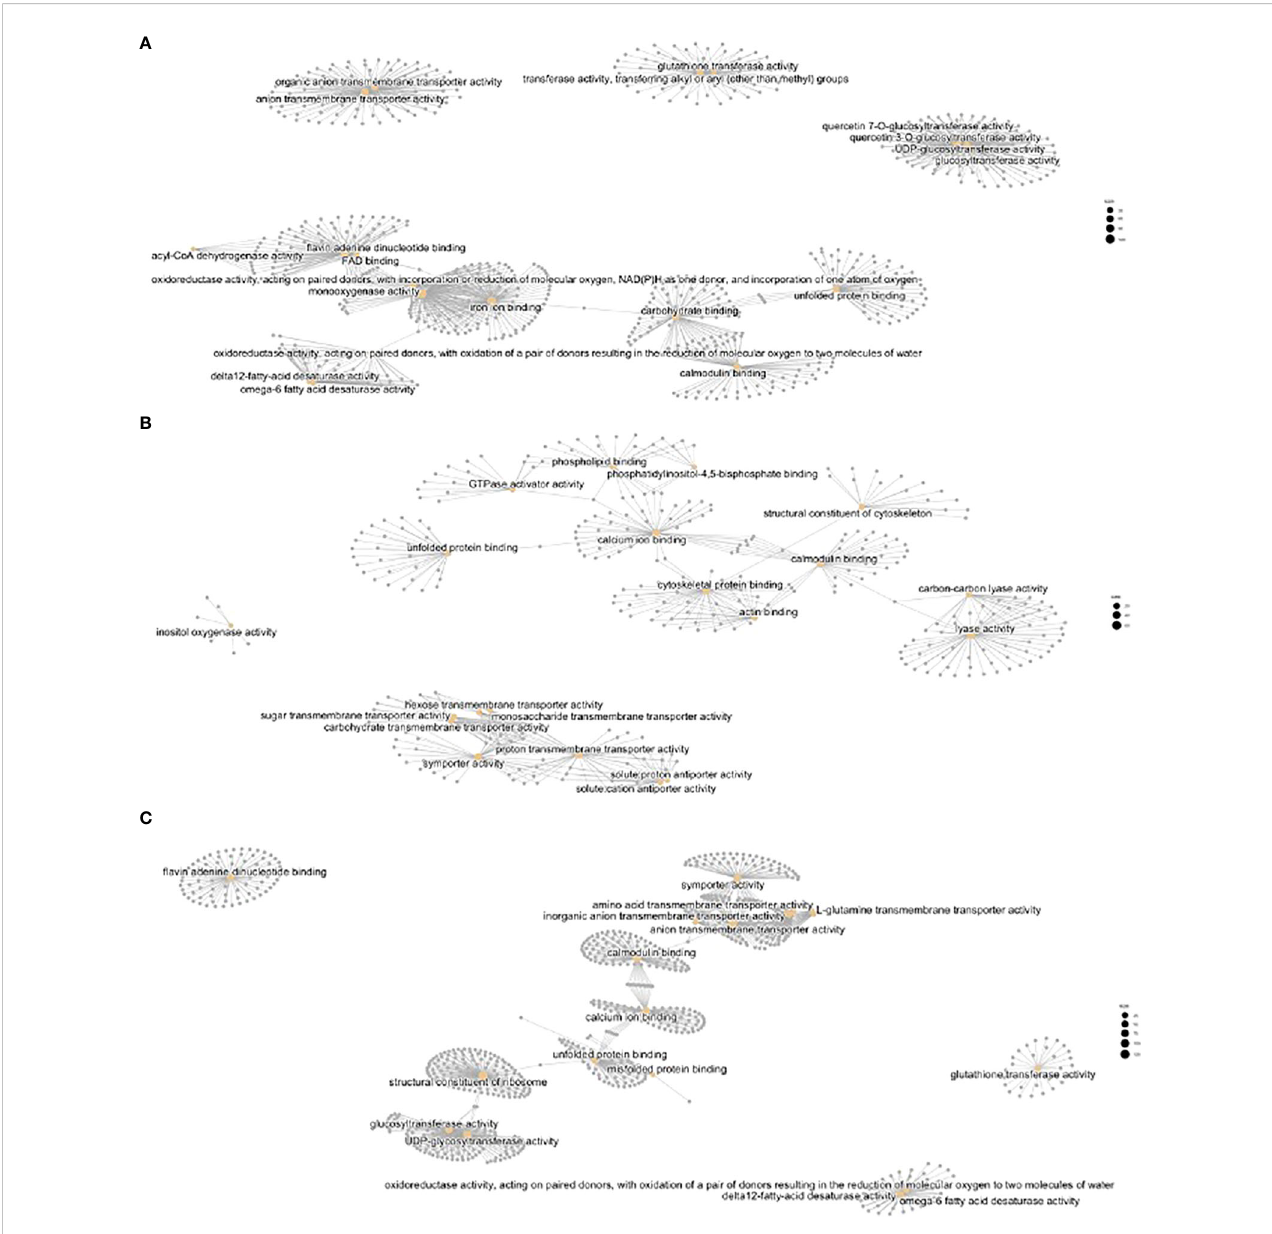
FIGURE 6 CNET plots of Molecular Functions with differential regulation. (A) Heat vs control, (B) cold vs control, (C) heat vs